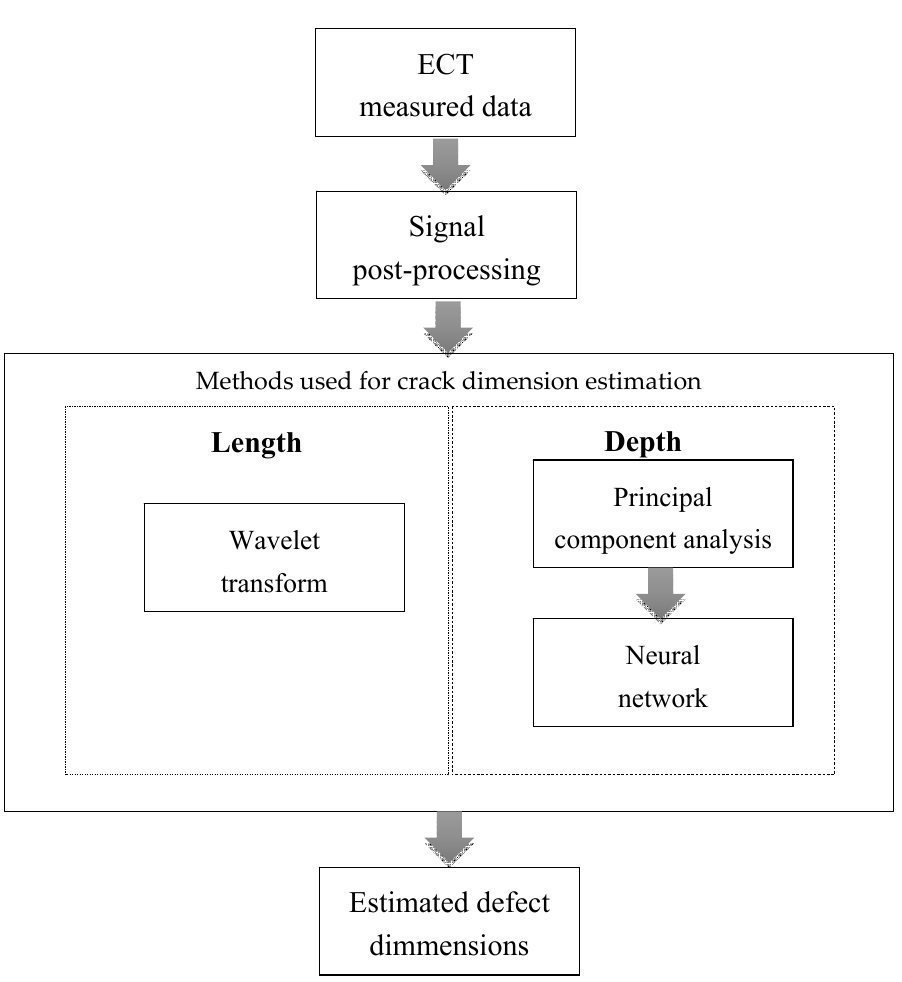
Figure 1. Flowchart of proposed new inverse algorithm.